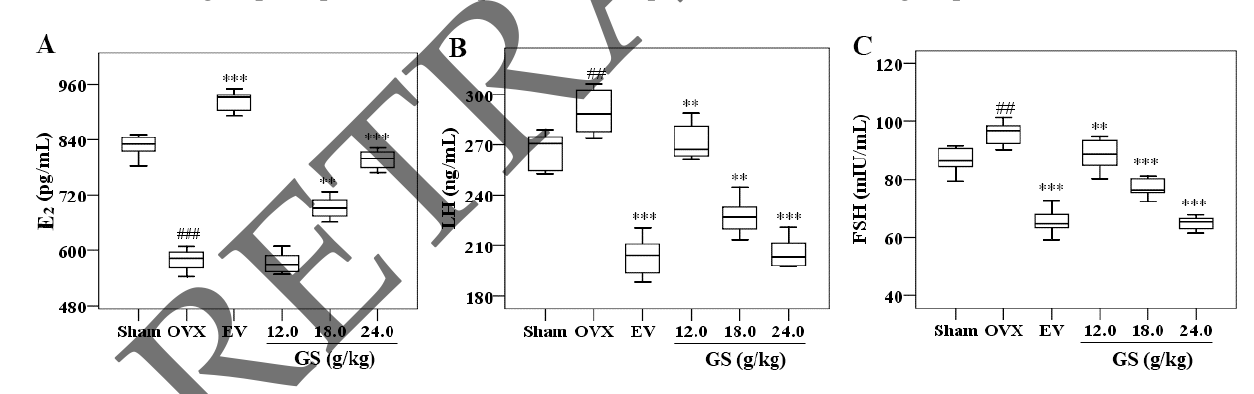
Figure 4. The effects of ginseng (GS) on serum estradiol (E and follicle-stimulating hormone (FSH) in OVX mice. Serum levels of E FSH ( C ) were measured at the end of the treatment period. Data are the mean standard deviation (SD) of samples from 10 mice. p- values are for the one-way ANOVA comparing the treatment group with untreated OVX mice. *** p < 0.001; ** p < 0.01; compared with the OVX group. ### p < 0.001; ## p < 0.01; compared with the sham